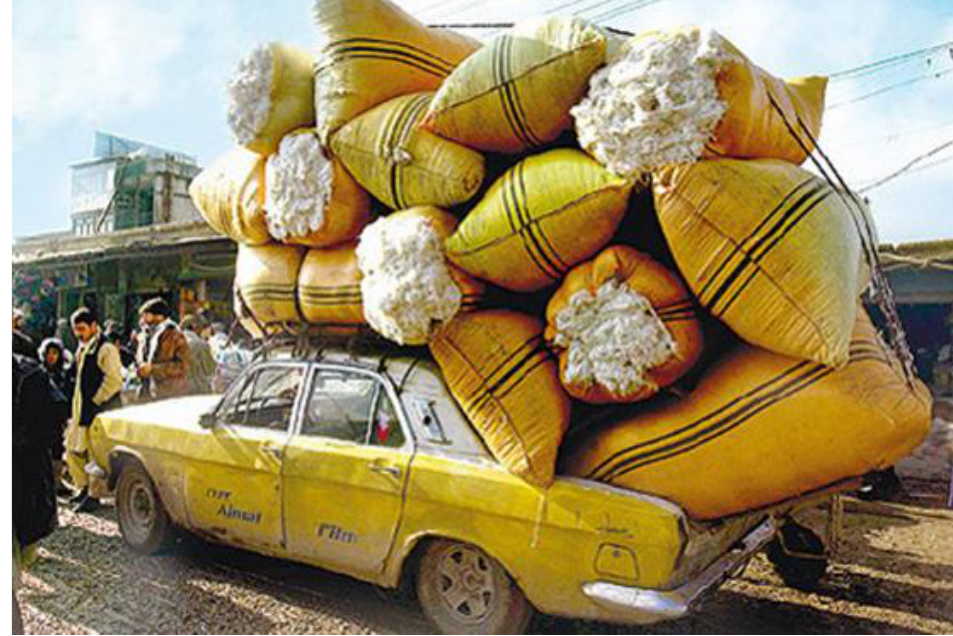
Figure 2. Manual Seed cotton harvesting: an example mode of transporting such harvested seed cotton to the gin (adopted with permission from [63]).